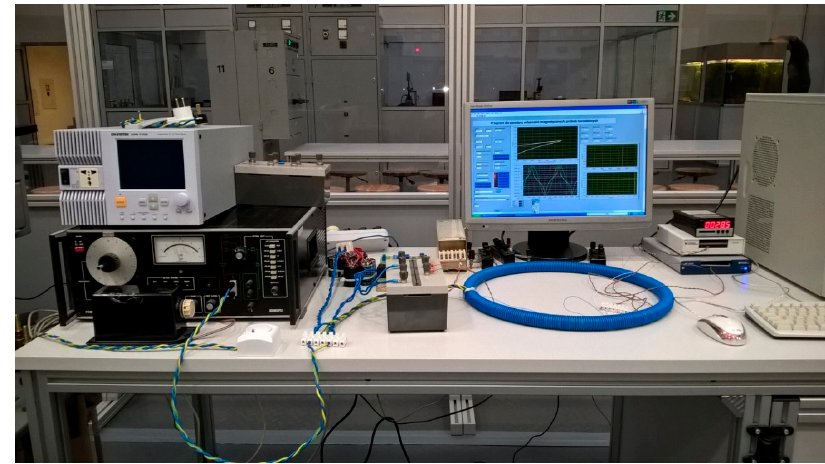
Figure 12. The wound toroidal sample with the measuring system.